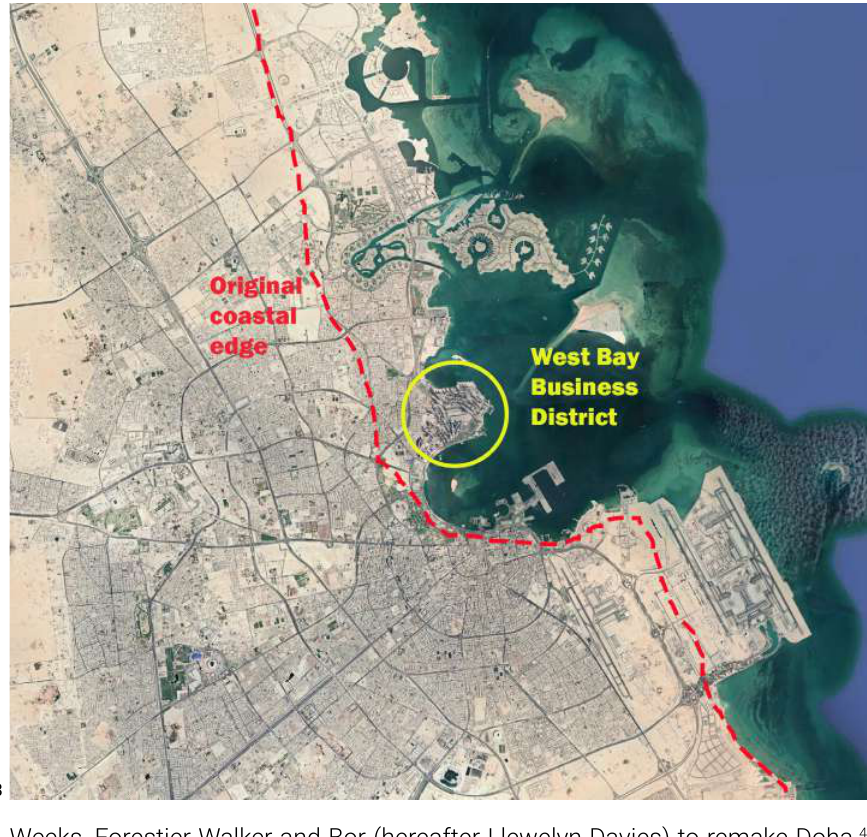
Fig. 3 Aerial image of Doha showing the pre-1950 coast edge and the West Bay central business district (Source: Google Earth,